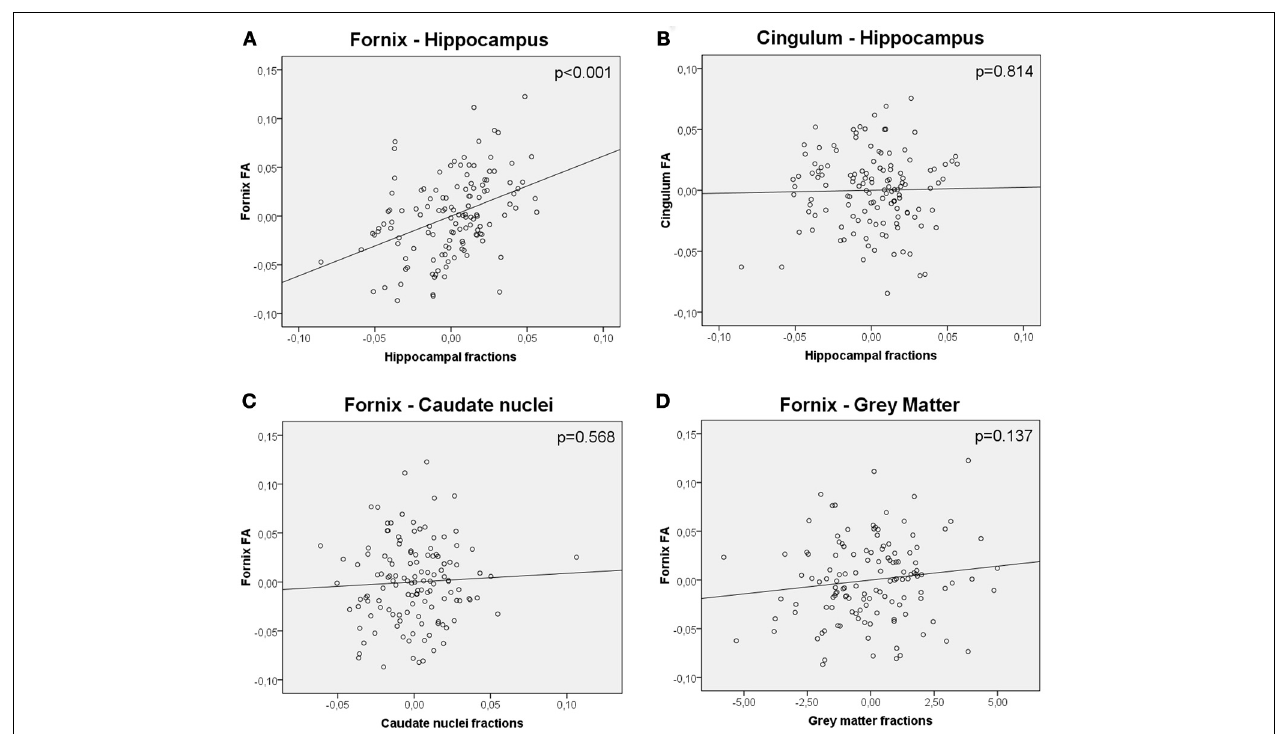
FIGURE 3 | Partial regression plots showing the relationship between (A) FA values of the fornix and hippocampal fractions (B) FA values of the cingulum and hippocampal fractions (C) FA values of the fornix and caudate nuclei fractions (D) FA values of the fornix and